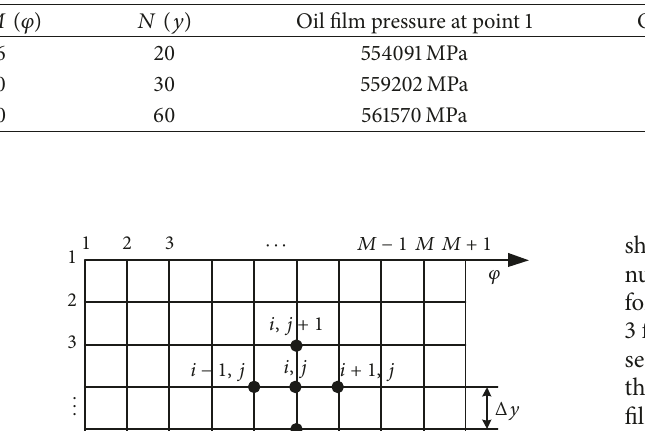
Table 1: The numbers of the node in 𝜑 and 𝑦 directions.